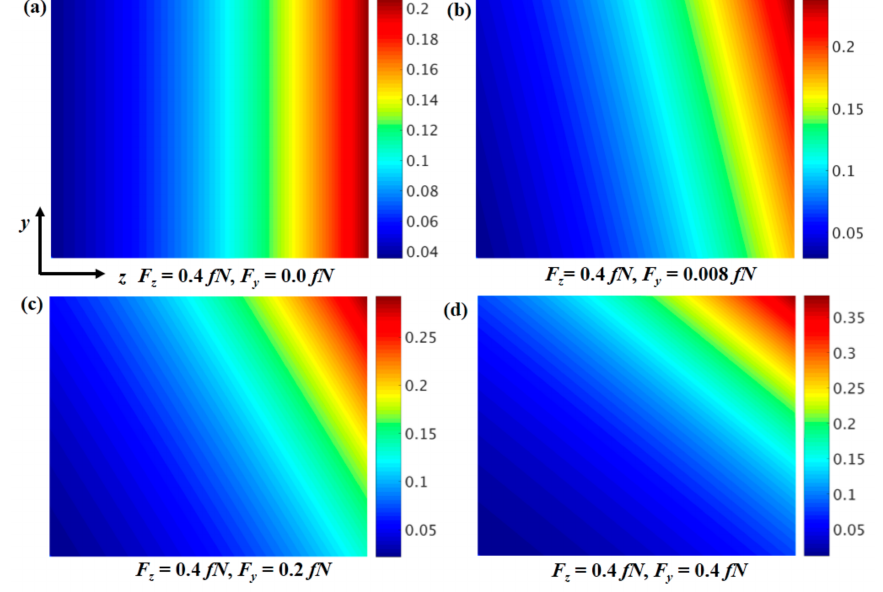
Figure 3. Two-dimensional nanoparticle concentration distributions after 1.2 × 10 3 s when the force in the z direction is fixed with 0.4 fN and the force in the y direction is selected as ( a ) 0, ( b ) 0.008 fN, ( c ) 0.2 fN, and ( d ) 0.4